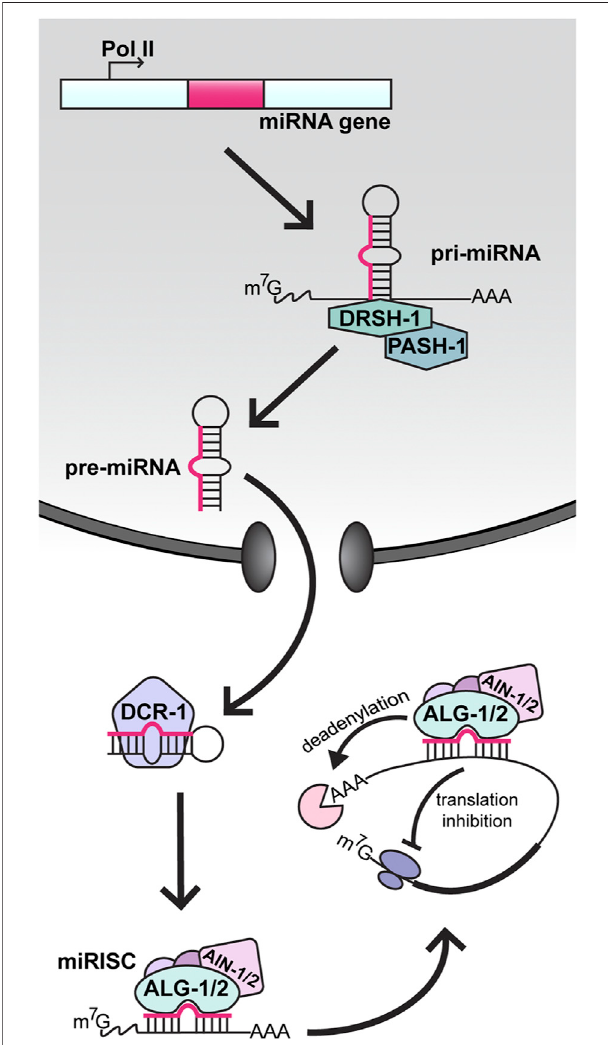
FIGURE 1 | MicroRNA biogenesis and function in C. elegans . In the nucleus, miRNA genes are transcribed by RNA polymerase II (Pol II) into long primary transcripts (pri-miRNAs). Pri-miRNAs are cleaved by Drosha (DRSH- 1) in complex with the RNA binding protein Pasha (PASH-1). The resulting precursor miRNA (pre-miRNA) hairpin is then transported to the cytoplasm, where processing by Dicer (DCR-1) produces a double stranded heteroduplex consisting of the mature miRNA and the passenger strand. The mature miRNA is loaded into an Argonaute protein (ALG-1 or ALG-2), forming the core microRNA-Induced Silencing Complex (miRISC). Through partial base-pairing, the miRNA positions miRISC on a target messenger RNA (mRNA) and the recruitment of AIN-1/2, along with other factors, causes repression of the target via deadenylation and/or inhibition of translation.